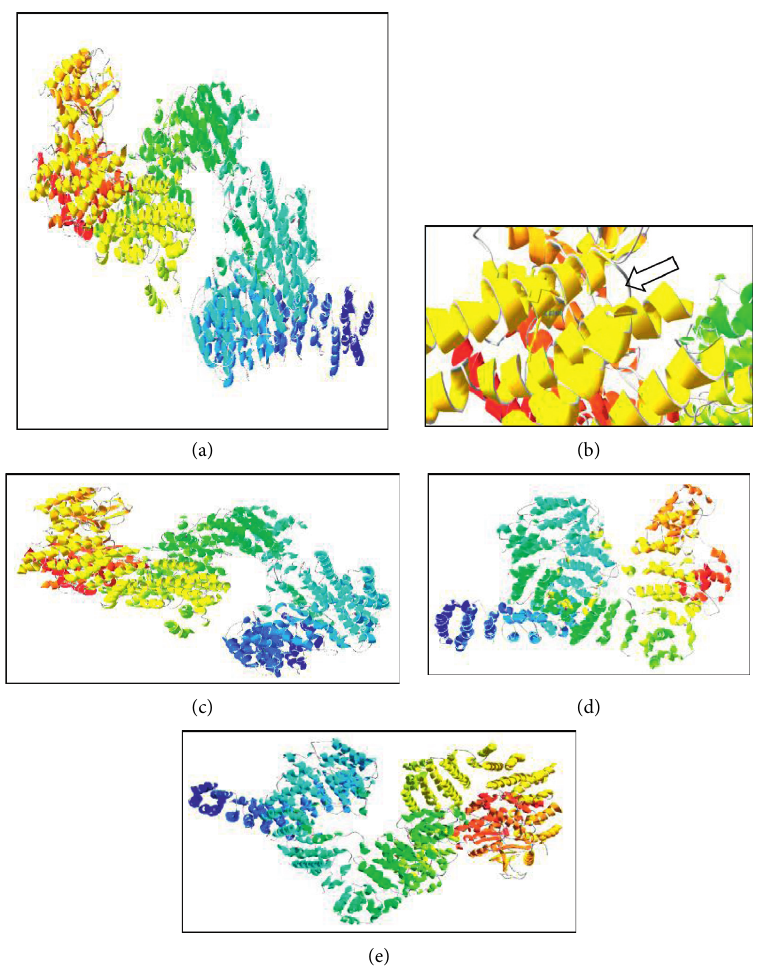
Figure 2: Protein modeling. (a) Normal ATM protein, (b) ATM protein structure with Glu at 2466 in helix, (c) structure of the protein with a missing helix, (d) structure of the ATM protein synthesized after deletion of GAAA from normal ATM mRNA at 5347_5350,and (e) 3D structure